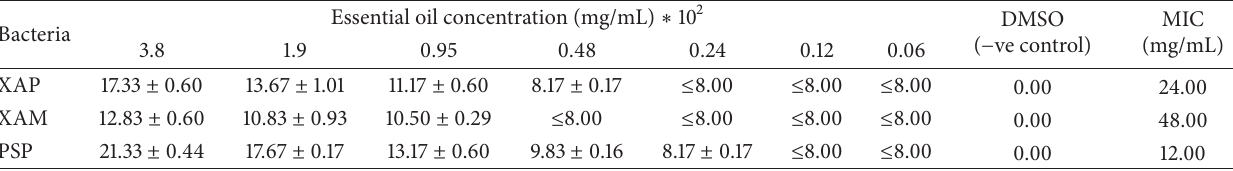
Table 2: Inhibition zones (mm) of three bacterialspecies at different concentrations of Tagetes minuta essential oils after 48 hours of